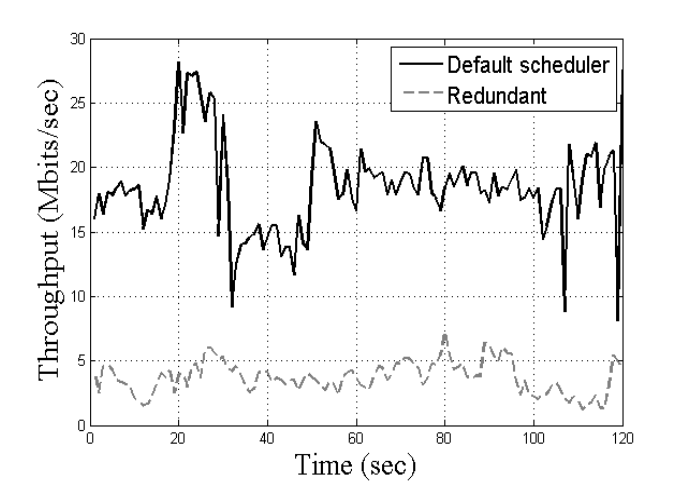
Figure 1. Throughput comparison of Multipath Transmission Control Protocol (MPTCP)